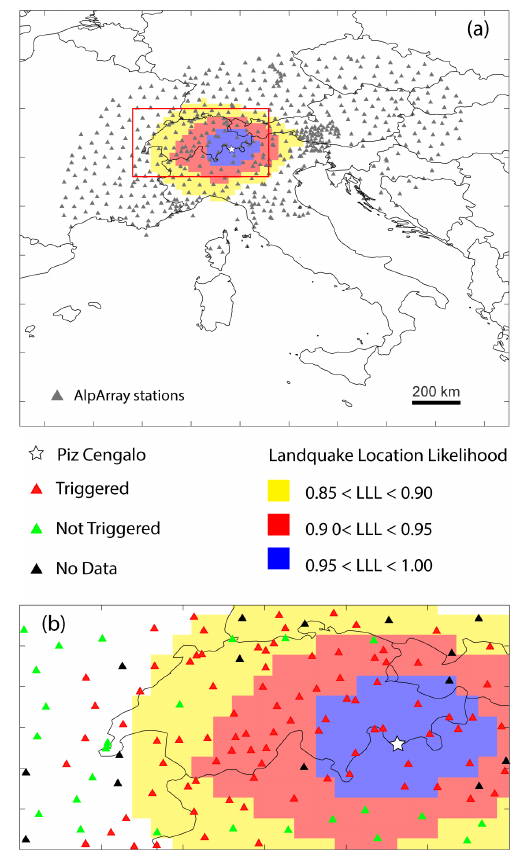
Figure 3. Likelihood of landquake location (LLL) based on the ar- rival time of seismic signals recorded by AlpArray stations. This ba- sic analysis of the seismic data is used to constrain the approximate location where a landslide event has occurred. (a) LLL over the en- tire AlpArray network. (b) Magnified view of the areas with high likelihood. The area 0.95 < LLL < 1.0 is used to confine the change detection analysis. The true location of the Piz Cengalo event (white star) is also shown. Table 1. Summary of the landquakes analyzed in this study and associated to the Piz Cengalo slope failure. ML (local magnitude) is estimated by SED, while average magnitude duration (MD) and volumes are computed, following Manconi et al. (2016), by consid- ering the event duration on all triggered AlpArray stations. Note that all LQ events have ML/MD less or equal to 0.8, i.e., they can be dis- cerned from earthquake events which typically have ML/MD ∼